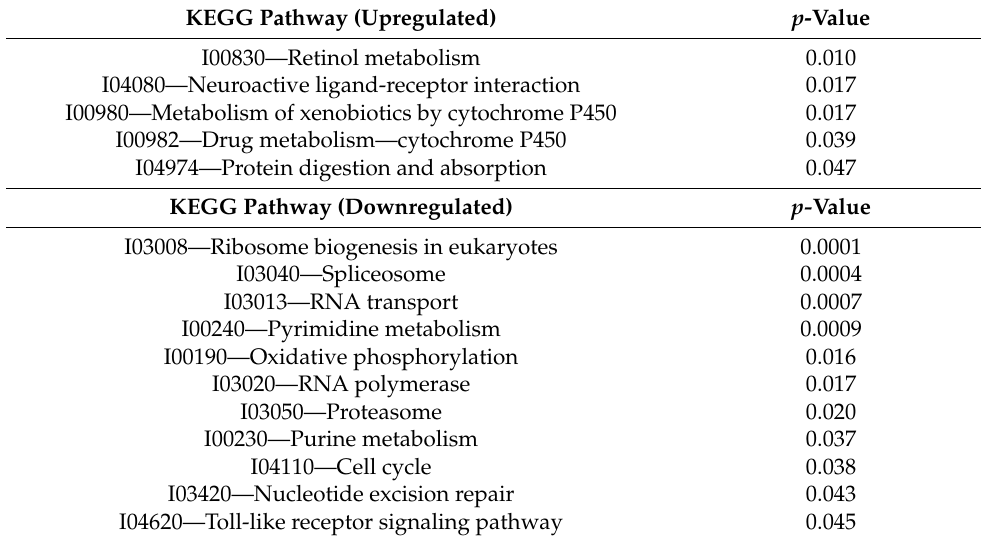
Table 2. Pathway enrichment analysis in LA-treated Caco-2 cells. Pathway enrichment demonstrates upregulated and downregulated KEGG pathways in LA-treated Caco-2 differentiated cells relative to untreated